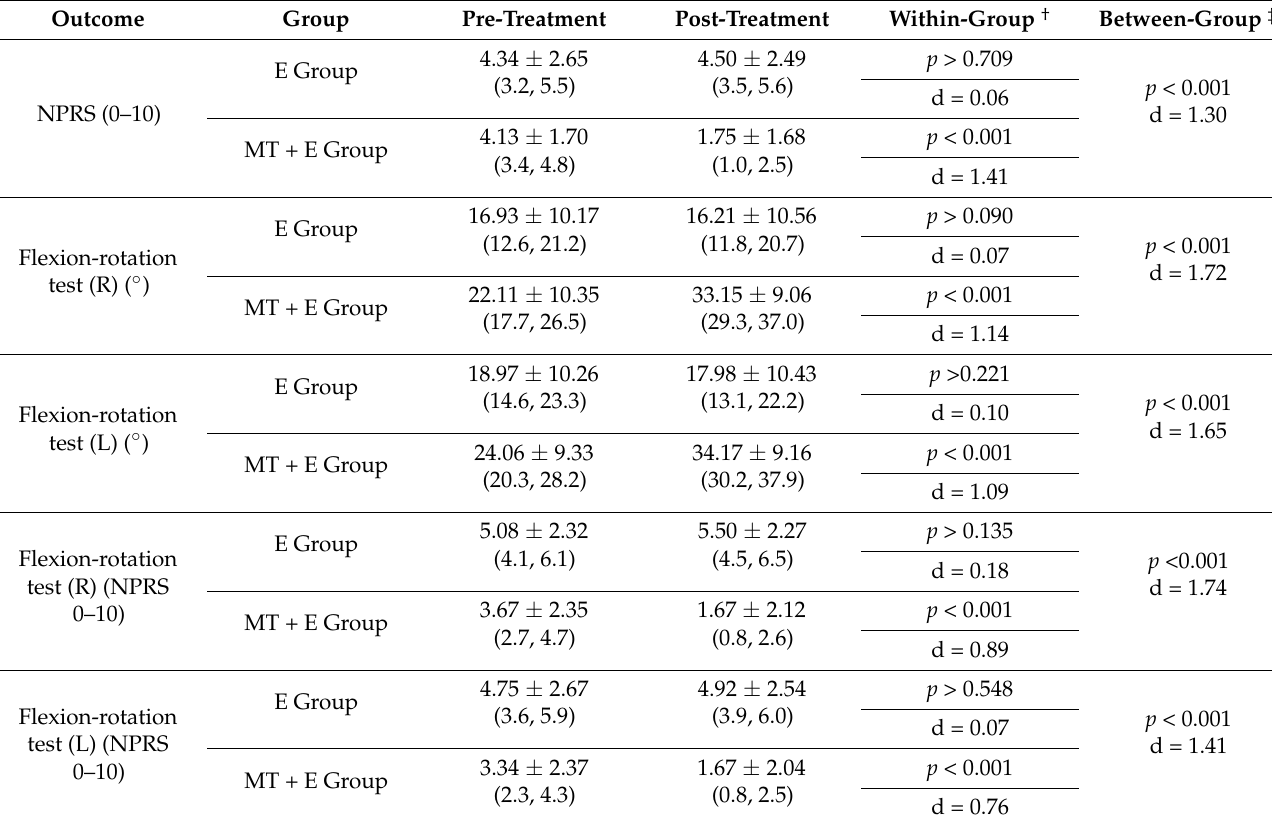
Table 2. Pre- and post-treatment in NPRS and flexion-rotation test